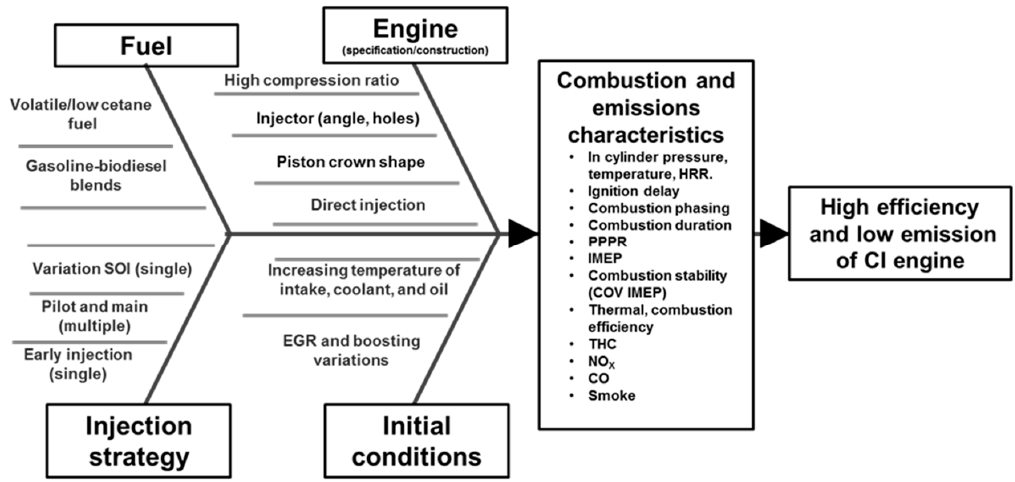
Figure 2. Flowchart of the potential strategies to obtain high efficiency and low emission CI engines fueled with gasoline-biodiesel blends.